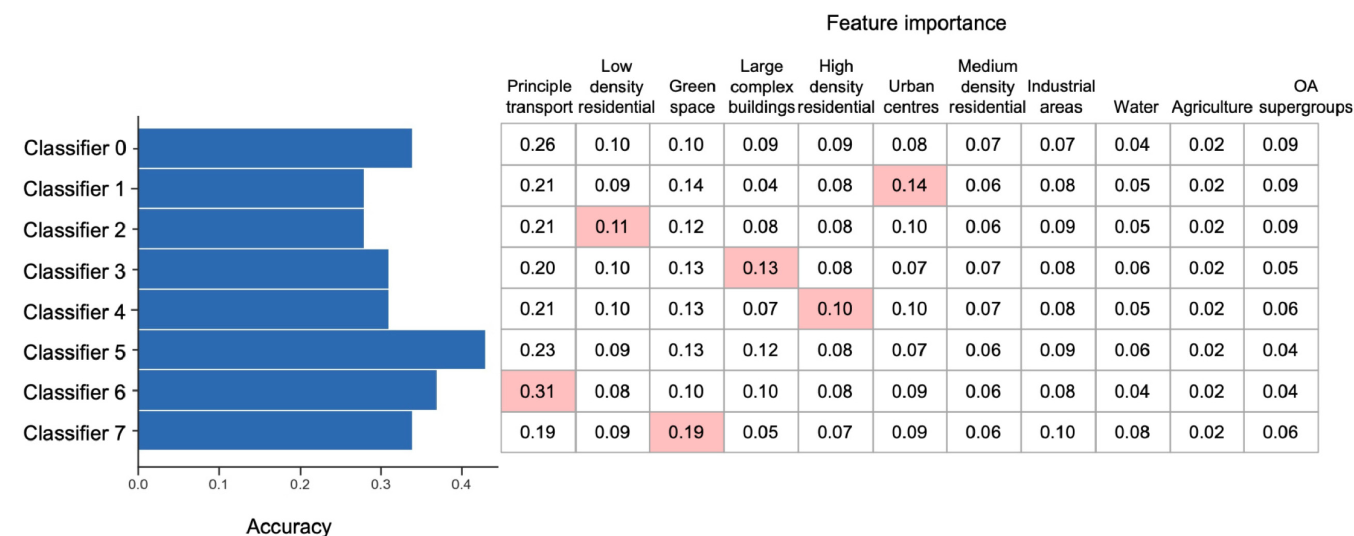
Fig 8. The accuracy values (left) and feature importance values of urban characteristics (right) in RF classifiers of different restriction phases. There are ‘Before lockdown’ (Classifier 0), ‘First national lockdown’ (Classifier 1), ‘Minimal lockdown restrictions’ (Classifier 2), ‘Reimposing restrictions’ (Classifier 3), ‘Three-tire restrictions’ (Classifier 4), ‘Second national lockdown’ (Classifier 5), ‘Four-tier restrictions’ (Classifier 6), and ‘Third national lockdown’ (Classifier